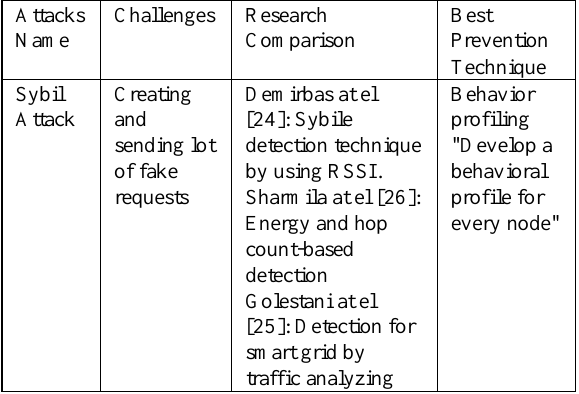
Table 1 . Summary of Network Layer Attacks and its